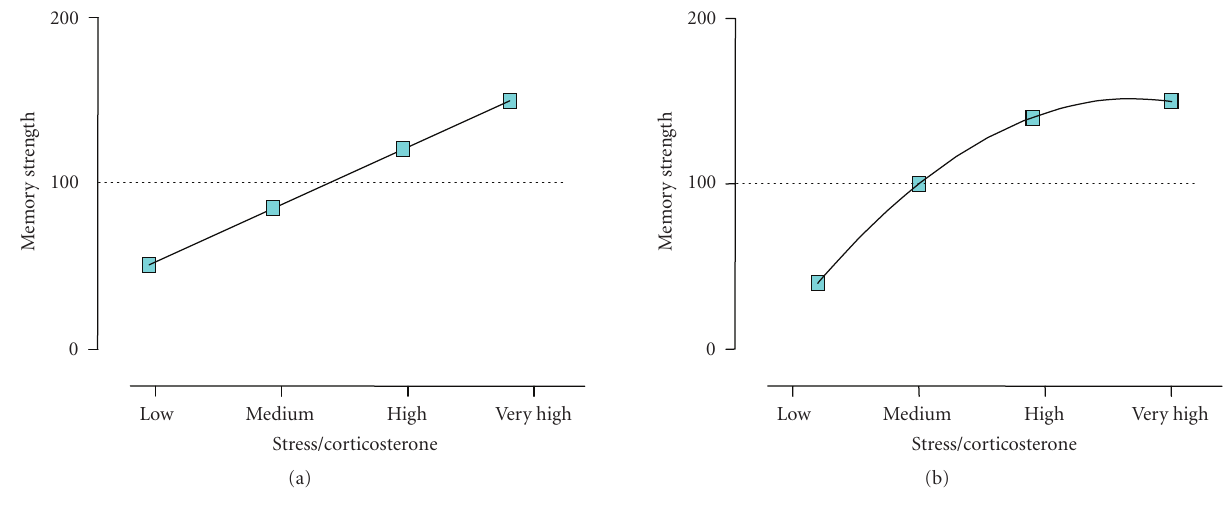
Figure 2: Impact of “intrinsic” stress on memory consolidation. Figures representing the linear (a) and linear-asymptotic (b) relationship between stress intensity (either defined by the stressor or by the physiological response indexed by the glucocorticoid corticosterone) ex- perienced during the consolidation period (provided learning has taken place during the previous learning phase) and the strength of the memory